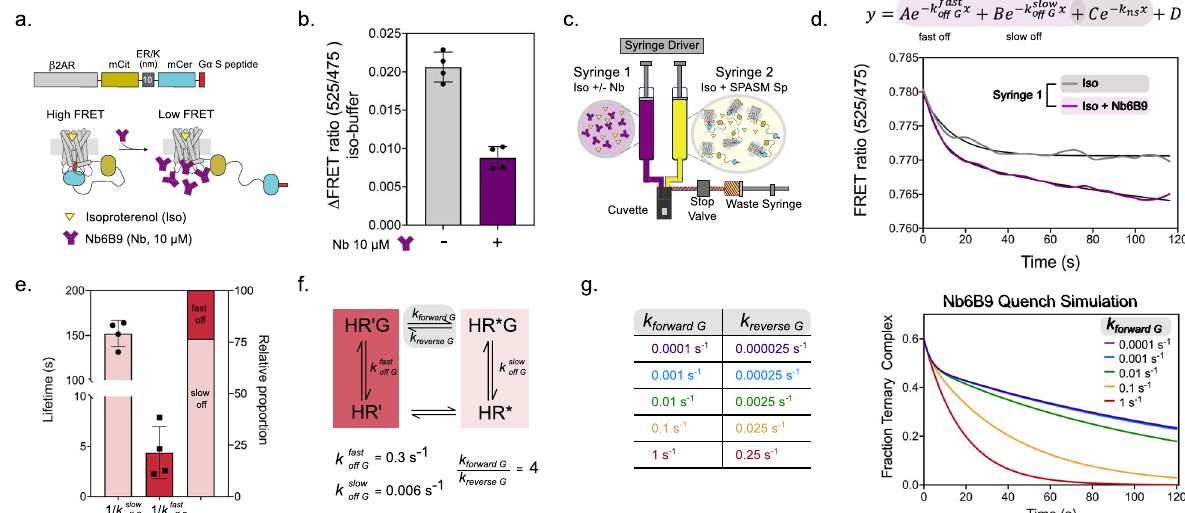
Fig. 1 G peptide-receptor interactions show two distinct kinetic pro fi les. a Schematic showing the FRET construct and Δ FRET assay. Nb6B9 binds free receptor (HR ’ and HR*) to quench the agonist activated β 2AR interaction with Spep in β 2AR-Spep SPASM sensors in native membranes prepared from Hek293T cells. b Change in FRET ratio (mCit/mCer) with isoproterenol treatment (iso, 100 μ M) with and without of 10 μ M Nb6B9. Nb6B9 decreases the Spep activation. Data are presented as mean + /- the standard deviation from 4 membrane preparations ( n = 4). c Schematic of the stopped- fl ow injection set-up used to measure decay in the FRET ratio of agonist activated β 2AR-Spep SPASM sensors after mixing with 10 μ M Nb6B9. Both syringes contain 100 μ M isoproterenol. d Representative decay curve of the decrease in FRET ratio over time when syringe 1 contains 100 μ M iso (grey) or 100 μ M iso + 10 μ M Nb6B9 (purple). The iso curve (grey) was fi t a single exponential decay with the rate k ns . The Nb6B9 decay (purple) was fi t to a triple exponential decay, constraining one decay to the iso fi t (see Supplementary Fig 7 for all decay curves and fi tting parameters). e Lifetime (1/ k off G ) of two states of the Nb6B9 decay and relative proportion of the slow off and fast off states. Data are presented as mean + / − standard deviation from 4 membrane preparations ( n = 4). f Kinetic model with constants constrained by experimentally measured rates. g Simulated Nb6B9 quench data show the interconversion rates from HR ’ G → HR*G must have lifetimes lower than the duration of the decay (see Supplementary Figure 8 for details of modeling). Source data are provided in the Source Data (Fig. 1e, Supplementary Fig. 7). Our data reveals a combination of weak ( k off = 0.3 s − 1 ) and strong interactions ( k off = 0.006 s − 1 ) of β 2AR with Spep, with the strong interaction dominating the kinetic pro fi le (75%; Fig. 1e). The different interaction af fi nities observed are consistent with the presence of two distinct states in the β 2AR-Spep interaction.